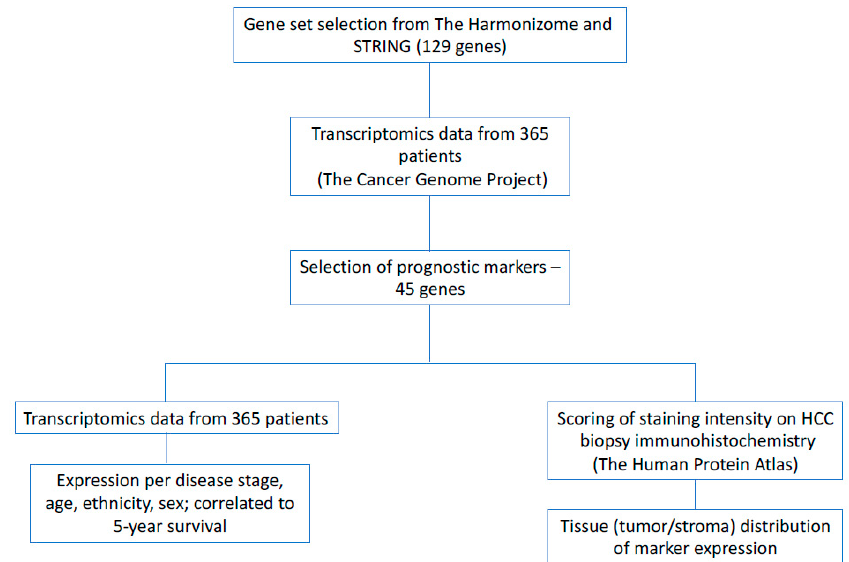
Figure 1. The method used for selecting UPR-associated genes, determining their prognostic value in HCC, and comparing and presenting their expression to different patient variables.